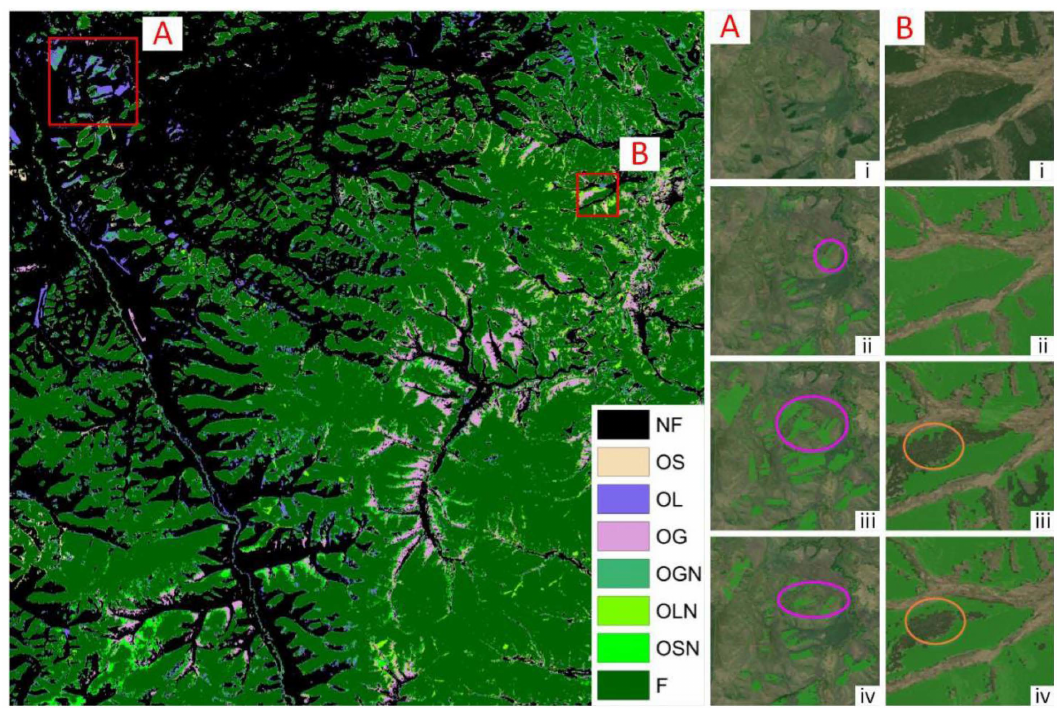
Figure 11. Classification results of images from different sensors in area